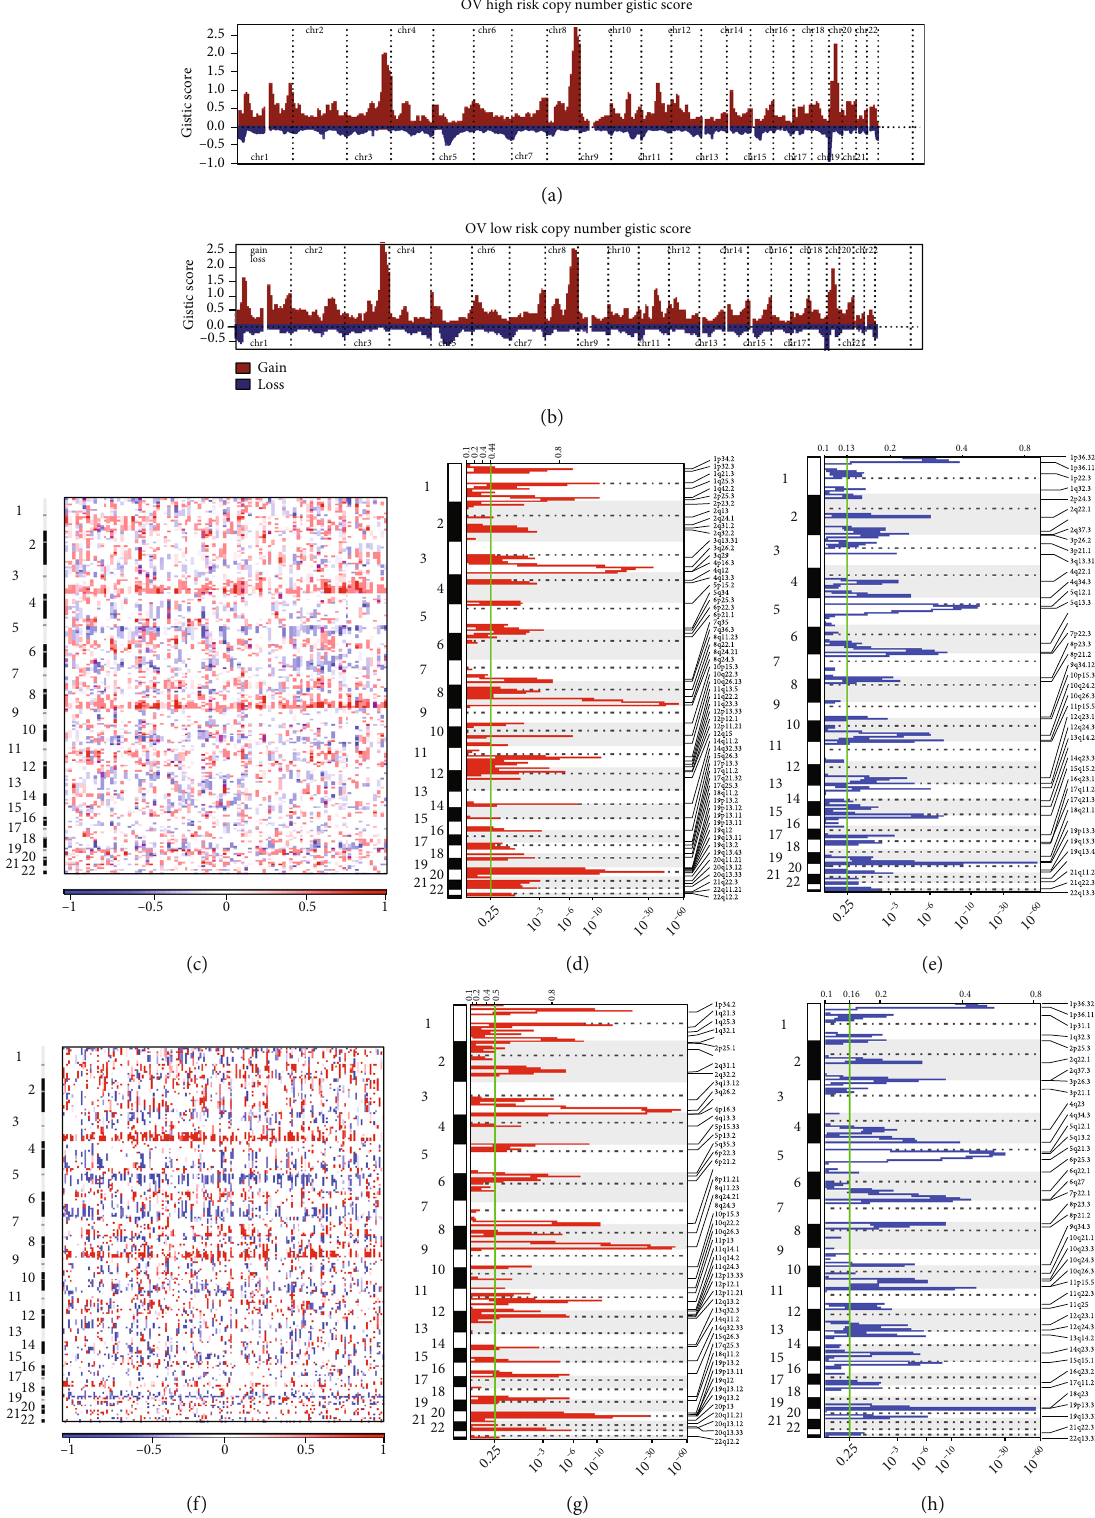
Figure 3: CNV di ff erences between high-MS and low-MS groups. (a) OV high risk copy number GISTIC score. (b) OV low risk copy number GISTIC score. (c – h) The exact locations of the ampli fi